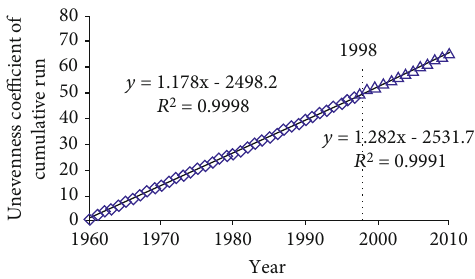
Figure 5: Unevenness coe ffi cient of cumulative runo ff .